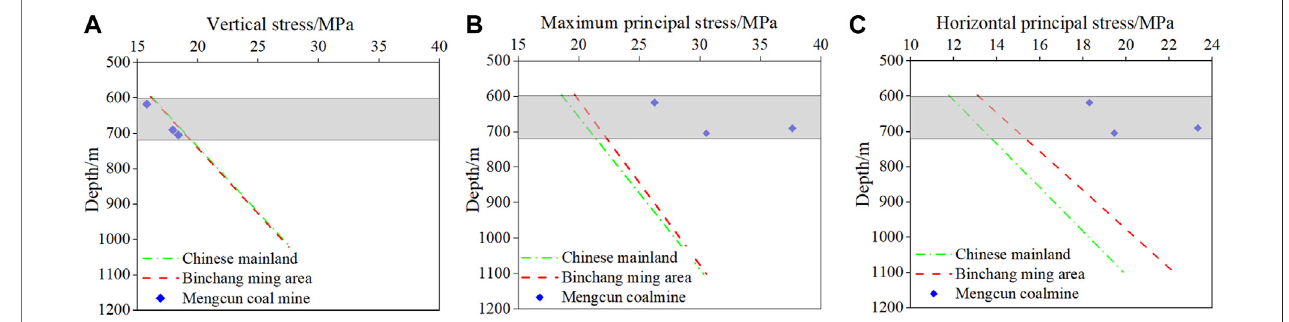
Frontiers in Earth Science |